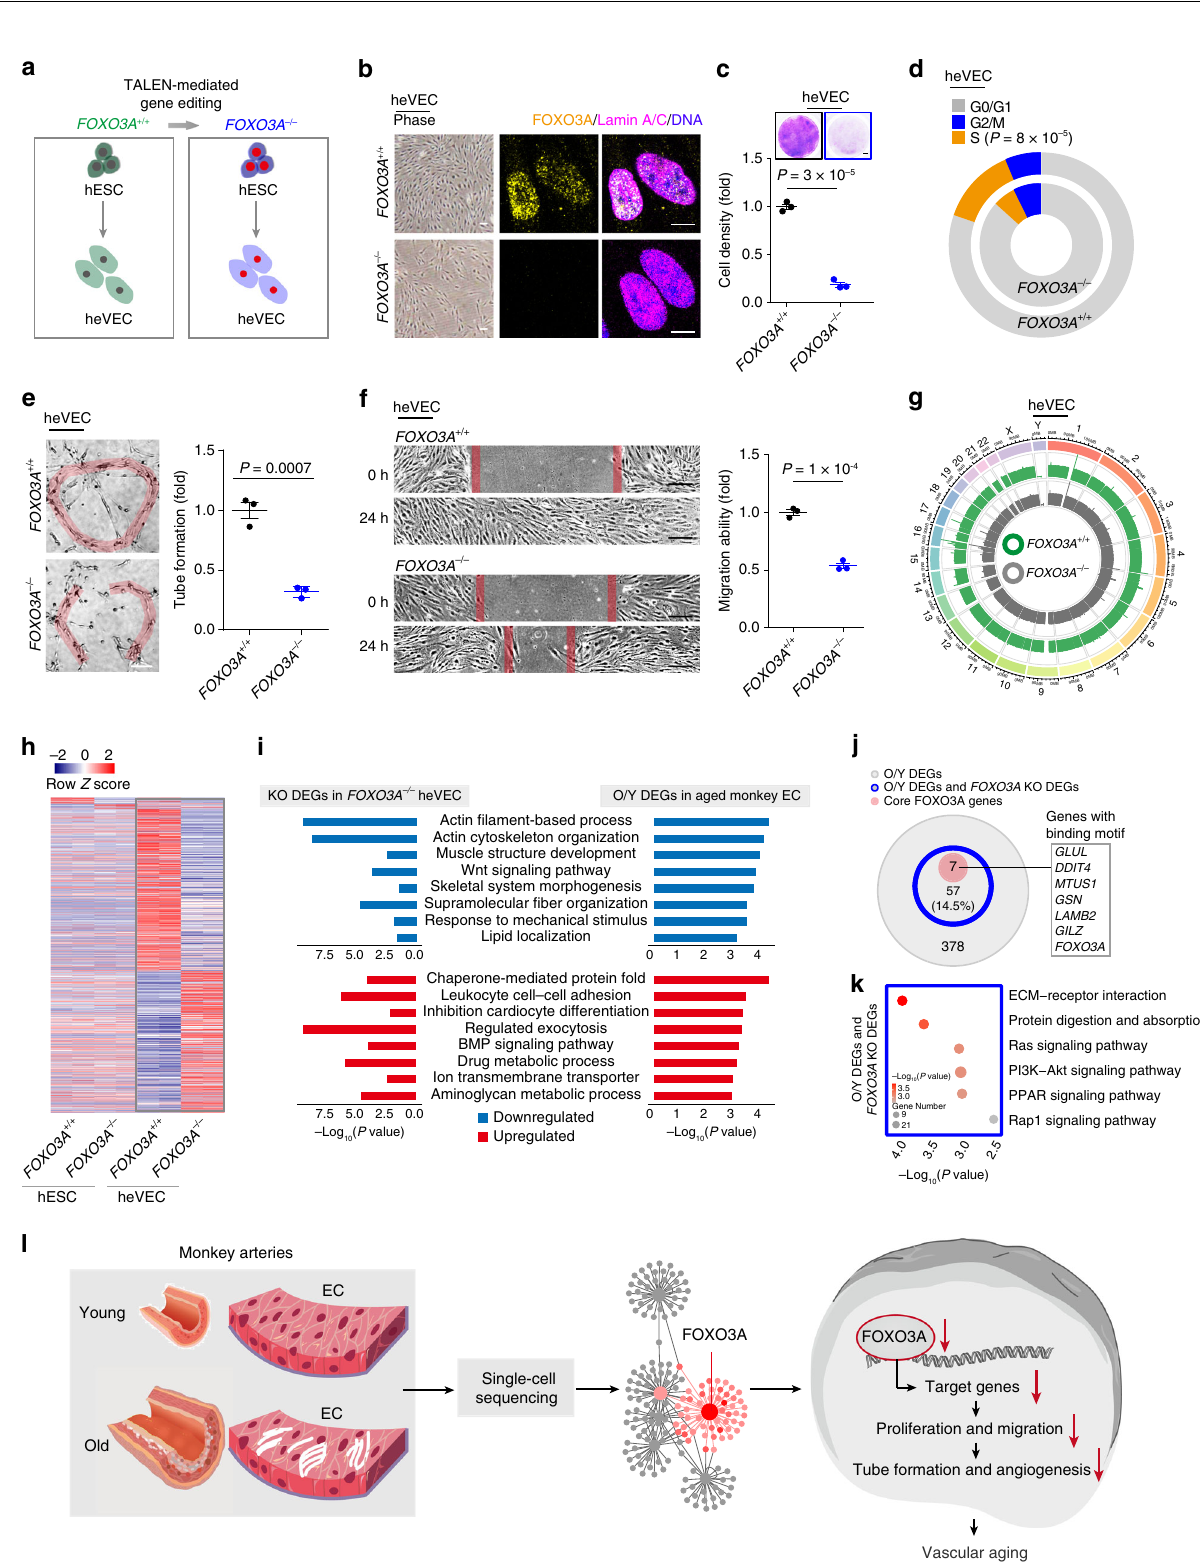
arteries 38 , cell classes and zonation in brain vasculature 39 , and during primate vascular aging. immune cell population in mouse atherosclerosis 40 . Importantly, we identi fi ed FOXO3A as a central protective factor in safe- underlying primate vascular aging provide a valuable resource to guarding primate vascular homeostasis. FOXO3A is ubiquitously the geroscience community on top of the previous single-cell expressed across the body with tissue-restricted and lineage- characterization of early progenitor cells that build coronary speci fi c functions in promoting healthspan and longevity 33,41 .